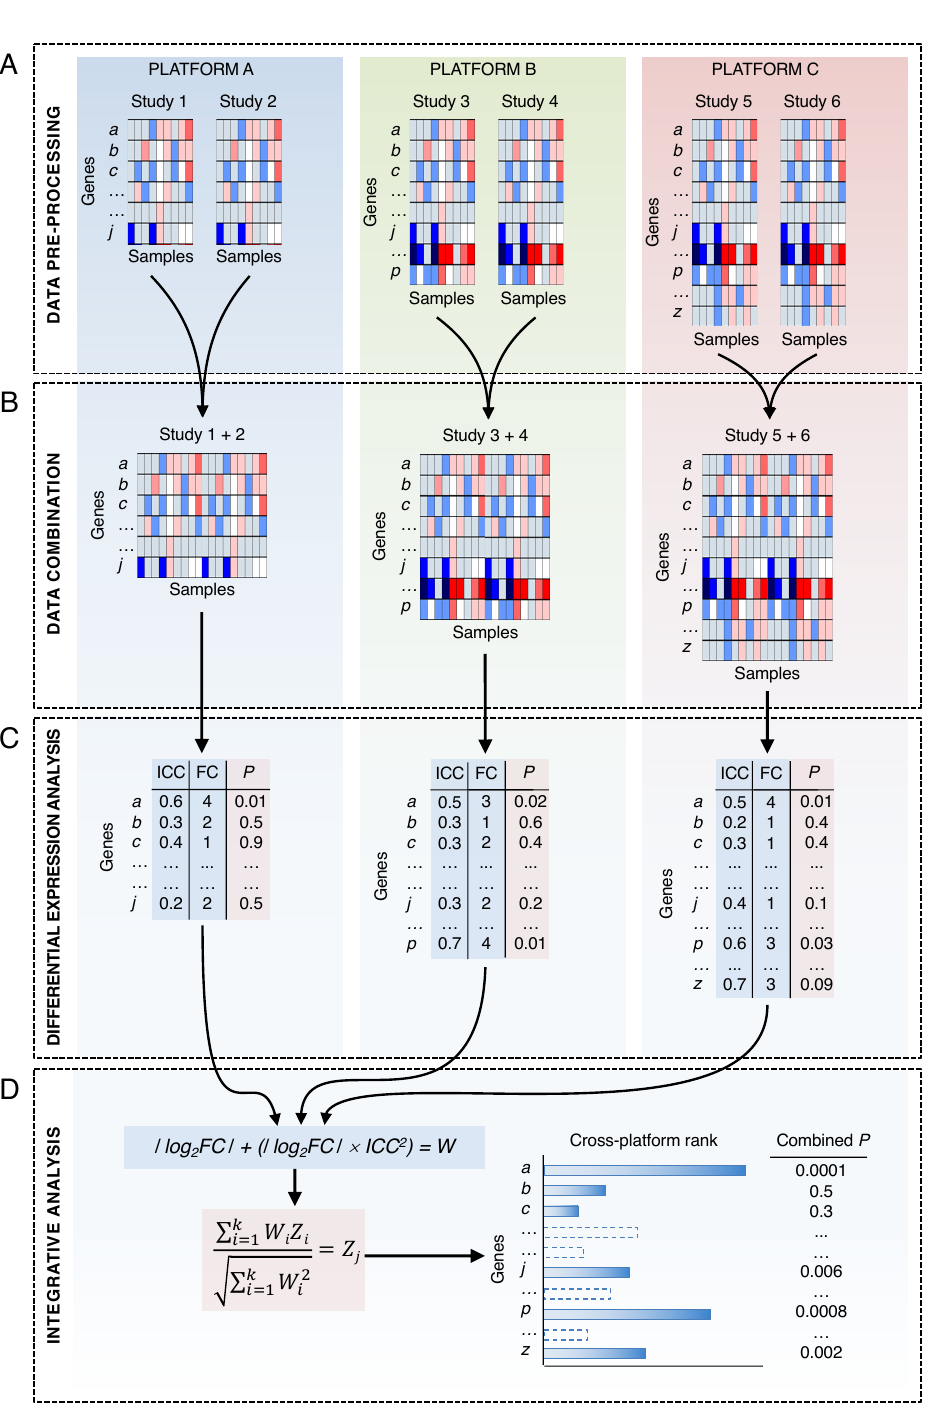
Figure 2. The cross-platform integrative analysis workflow. ( A ) Pre-processing of multi-study expres- sion data generated using different technologies and covering various sets of genes. ( B ) Combination step including normalization and batch-effect adjustment of expression data derived from the same platform and containing the same set of genes. ( C ) Per-platform differential expression analysis outputting fold-change and p-value (FC, P), and integrative correlation coefficient (ICC) for each gene. ( D ) Application of the integrative analysis model, based on the weighted Stouffer’s algorithm, to compute combined p -values and determine the cross-platform gene rankings (detailed in